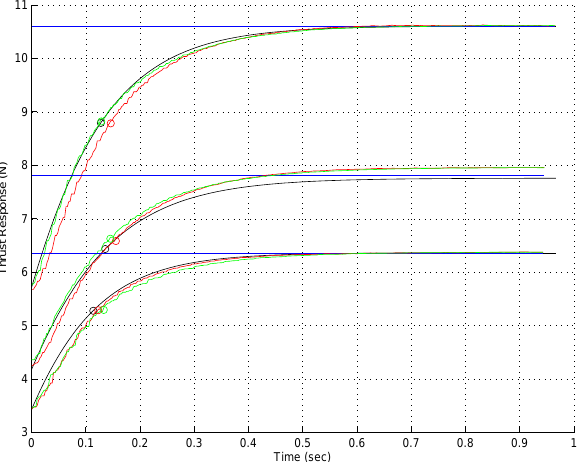
Figure 9: Thrust response per propeller, Test Case II. Top: 4 Actuators, Middle: 6 Actuators, Bot- tom: 8 Actuators. Blue: Input, Red: Accel- eration, Green: Deceleration, Black: Simula- tion model. The circles represent the thrust at the 63% rise